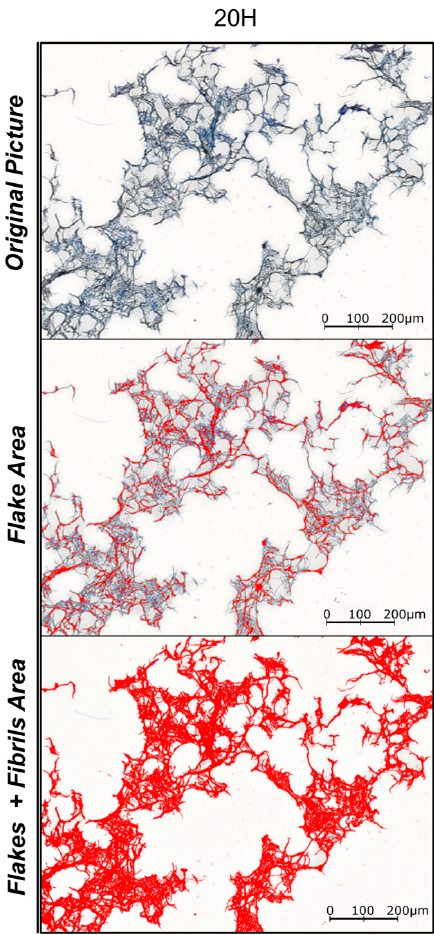
Figure 1. Example of the image analysis processing using ImageJ Software to identify Flakes and Total Detectable Area in one of the 800 pictures realized per samples, sample 20H.